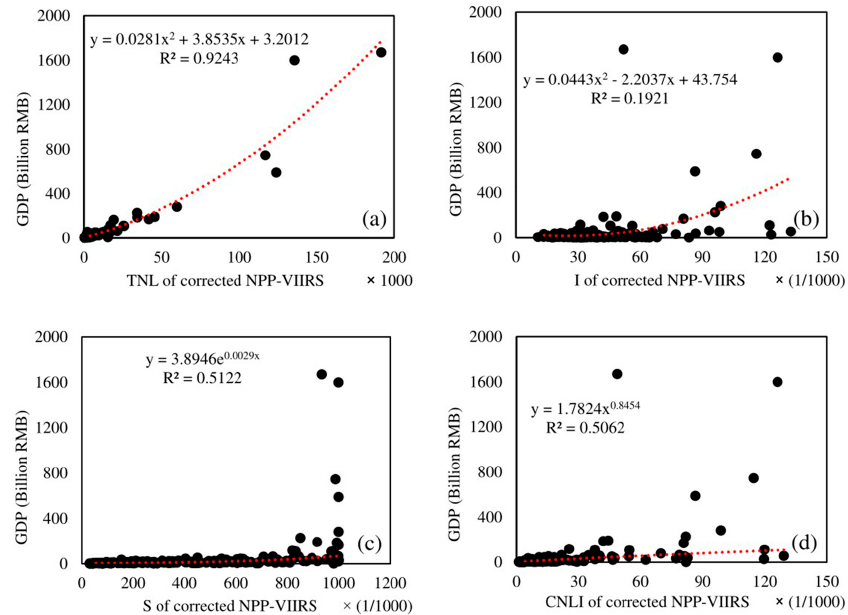
Figure 7. Statistical relationships between GDP and four light indices of corrected VIIRS data at the county level: ( a ) total nighttime light (TNL); ( b ) average nighttime light intensity (I); ( c ) proportion of intensely lit area (S); and ( d ) compounded nighttime light index (CNLI).